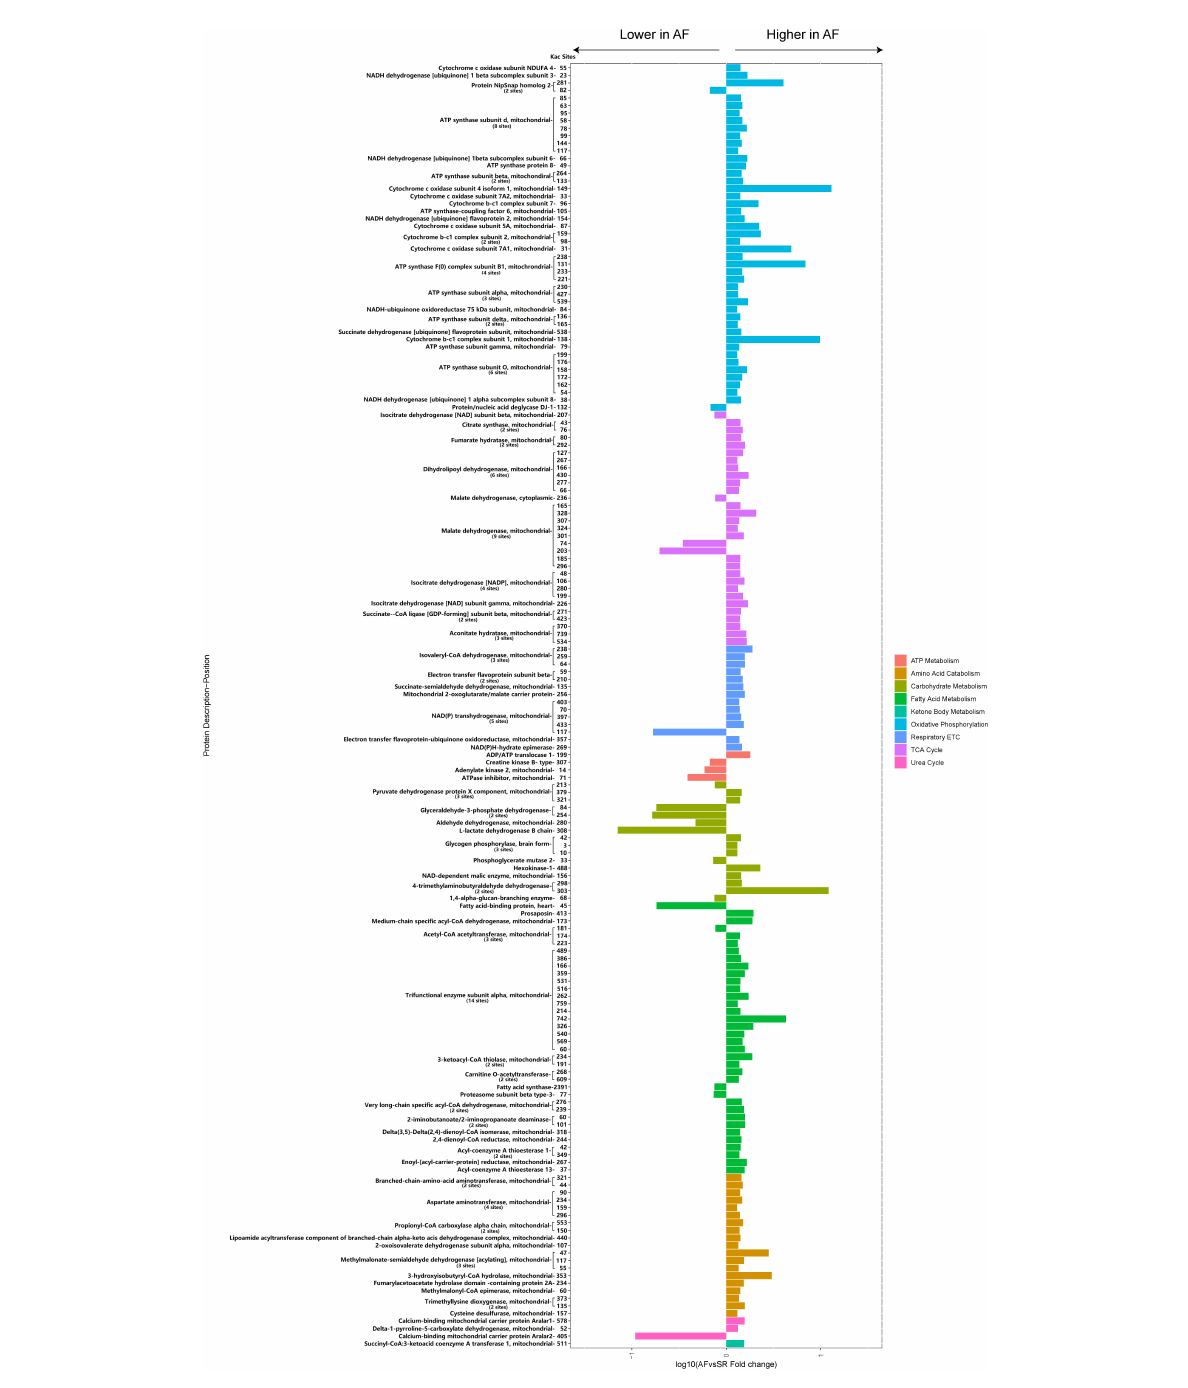
FIGURE7 Histogram bar and comparison of the AF/SR differentially expressed energy metabolism-related acetylated proteins and sites in LAA tissues. AF, atrial fibrillation; SR, sinus rhythm; LAA, left atrial appendage; ETC, electron transport chain; TCA cycle, citrate cycle.